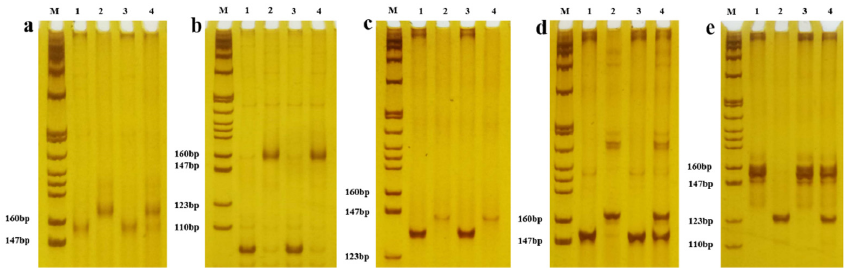
Figure 5. Screening of SSR markers between extreme phenotype DNA pools. Electrophoresis lanes: M is Marker pBR322 DNA/MspI; ( a ) molecular marker of umc1601 and 1, 2, 3, and 4 are Huangzao4, Jing7, Huangzao4 types of the mixed gene pool, and Jing7 types of the mixed gene pool, respectively; ( b ) molecular marker of umc1590 and 1, 2, 3, and 4 are Huangzao4, Jing7, Huangzao4 types of the mixed gene pool, and Jing7 types of the mixed gene pool; ( c ) molecular marker of umc1754 and 1, 2, 3, and 4 are Huangzao4, Jing7, Huangzao4 types of the mixed gene pool, and Jing7 types of the mixed gene pool; ( d ) molecular markers of bnlg1914 and 1, 2, 3, and 4 are Jing7, Chang7 ‐ 2, Jing7 types of the mixed gene pool, and Chang7 ‐ 2 types of the mixed gene pool; and ( e ) molecular marker of bnlg1335 and 1, 2, 3, 4 are Jing7, Chang7 ‐ 2, Jing7 types of the mixed gene pool, and Chang7 ‐ 2 types of the mixed gene pool.